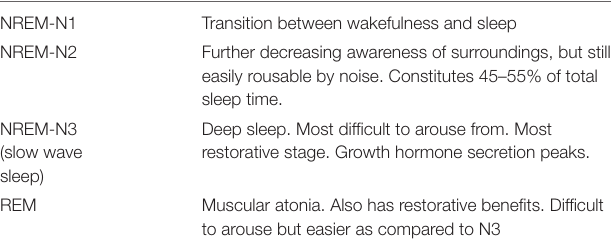
TABLE 1 | The normal sleep cycle. NREM-N1 Transition between wakefulness and